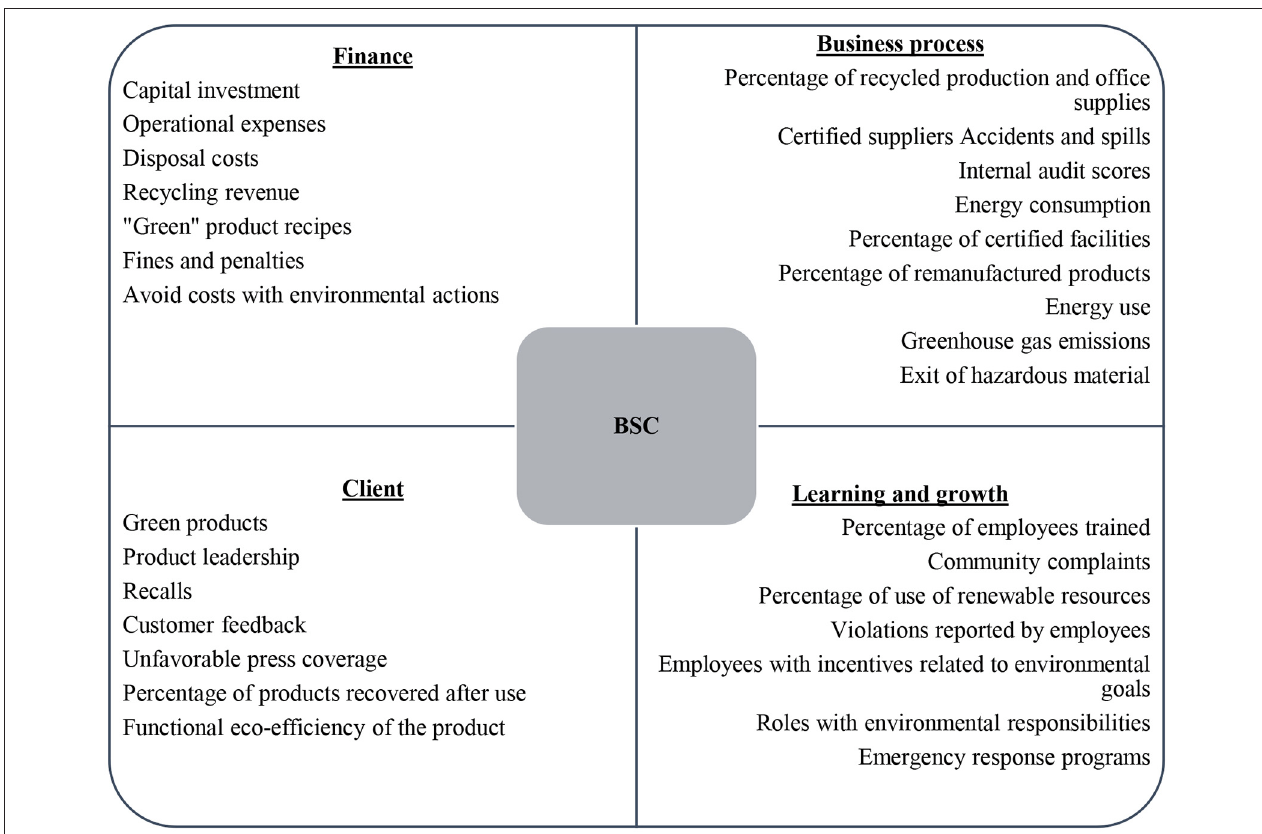
FIGURE 3 | Environmental performance measures by BSC categories. Source: Hervani et al. (2005).